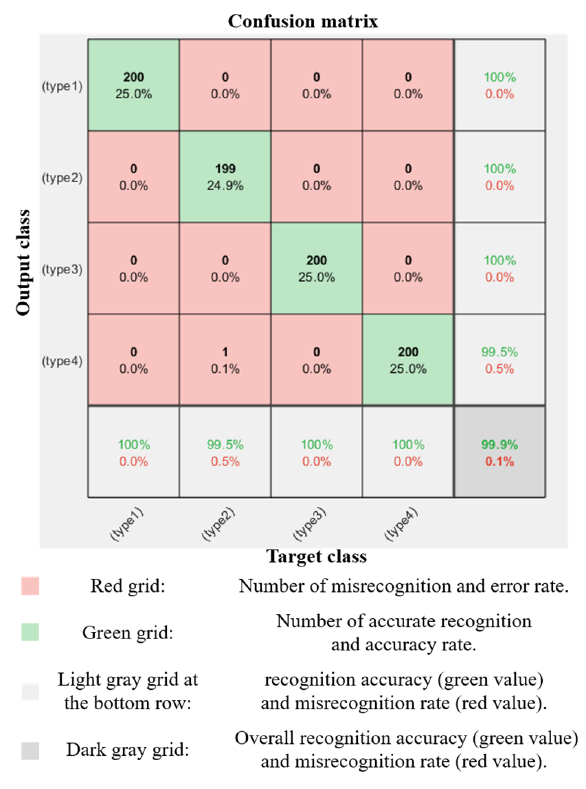
Figure 25. A confusion matrix of fault diagnosis